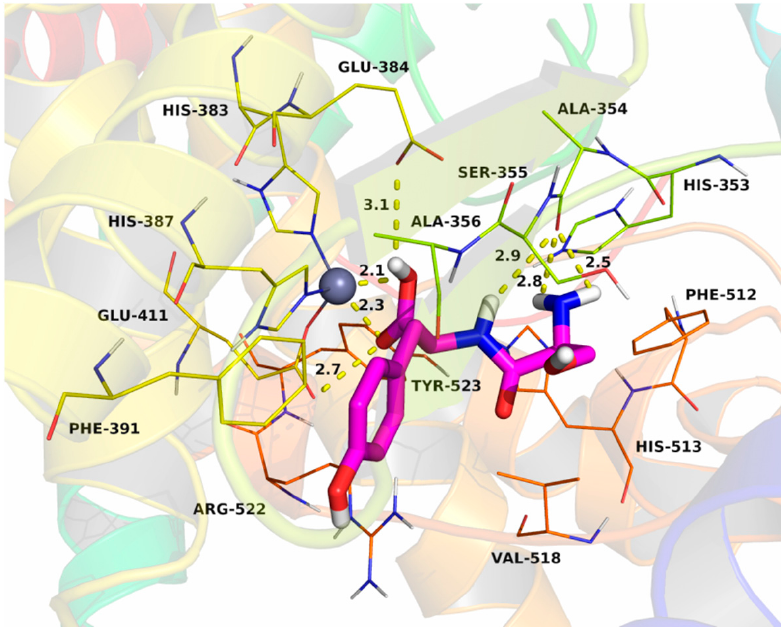
Figure 7. The docking of Ser-Tyr binding with the human ACE-C.